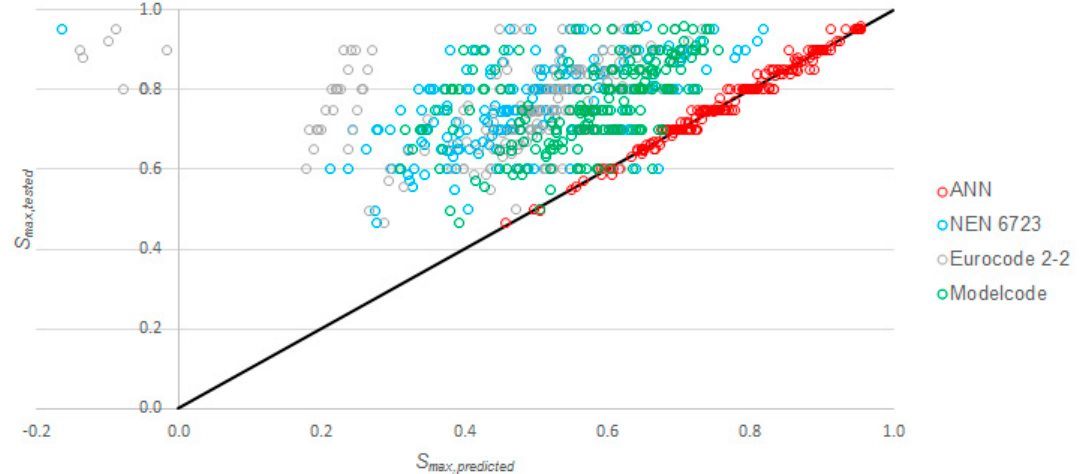
Figure 6. Comparison between tested and predicted values with code formulas and ANN-based model. Table 5. Statistical properties of V utot / V pred for all datapoints with AVG = average of V utot / V pred , STD